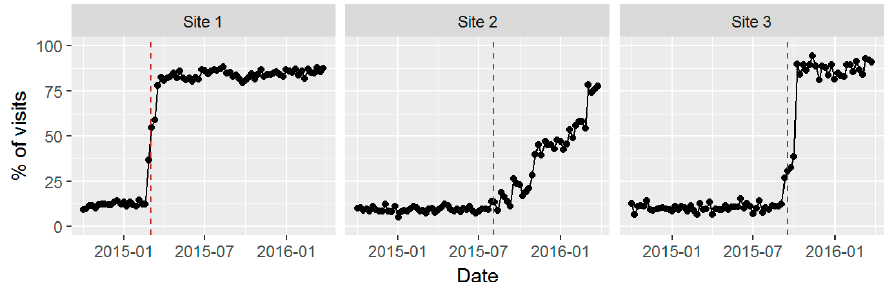
Figure 2. Screening for unhealthy alcohol use: percentage (%) of visits with screening by week, among providers implementing Behavioral Health Integration including the Sustained Patient-centered Alcohol-related Care (SPARC) program within three PC sites.